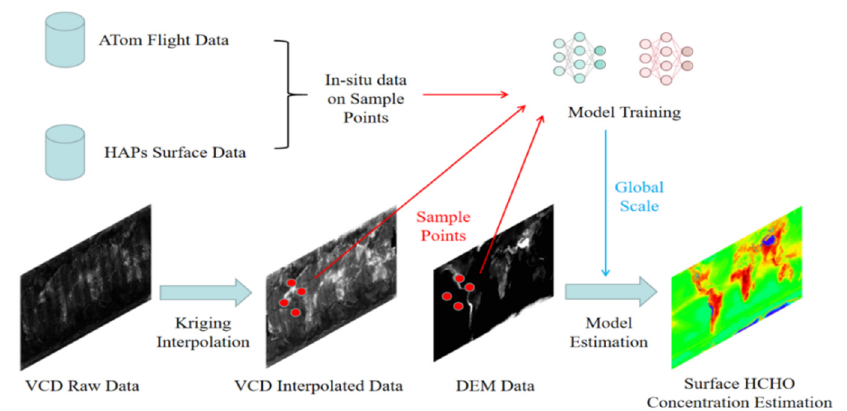
Figure 1. Data processing workflow.